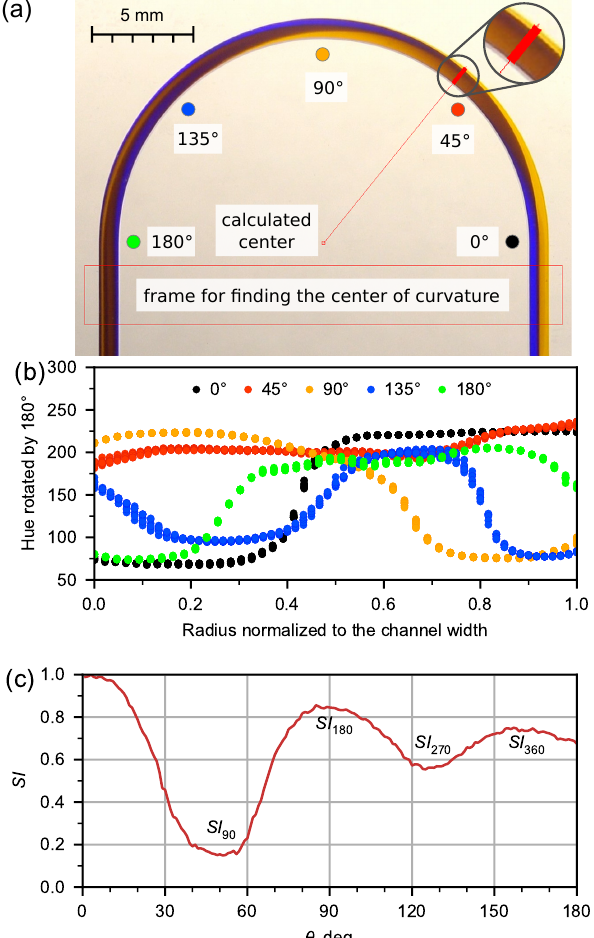
Figure 2. Analysis of experimental image of flow pattern for water at Q =5mL/min by means of developed application. ( a ) Automatic detection of curvature center and demonstration of selecting pixels set by the beam at fixed angle; ( b ) hue distribution in the channel in 5 various cross-sections; ( c ) dependence of switching index ( SI , normalized standard deviation of selected pixels hue) on the angle θ with labeled extremes corresponding to various flow recirculation